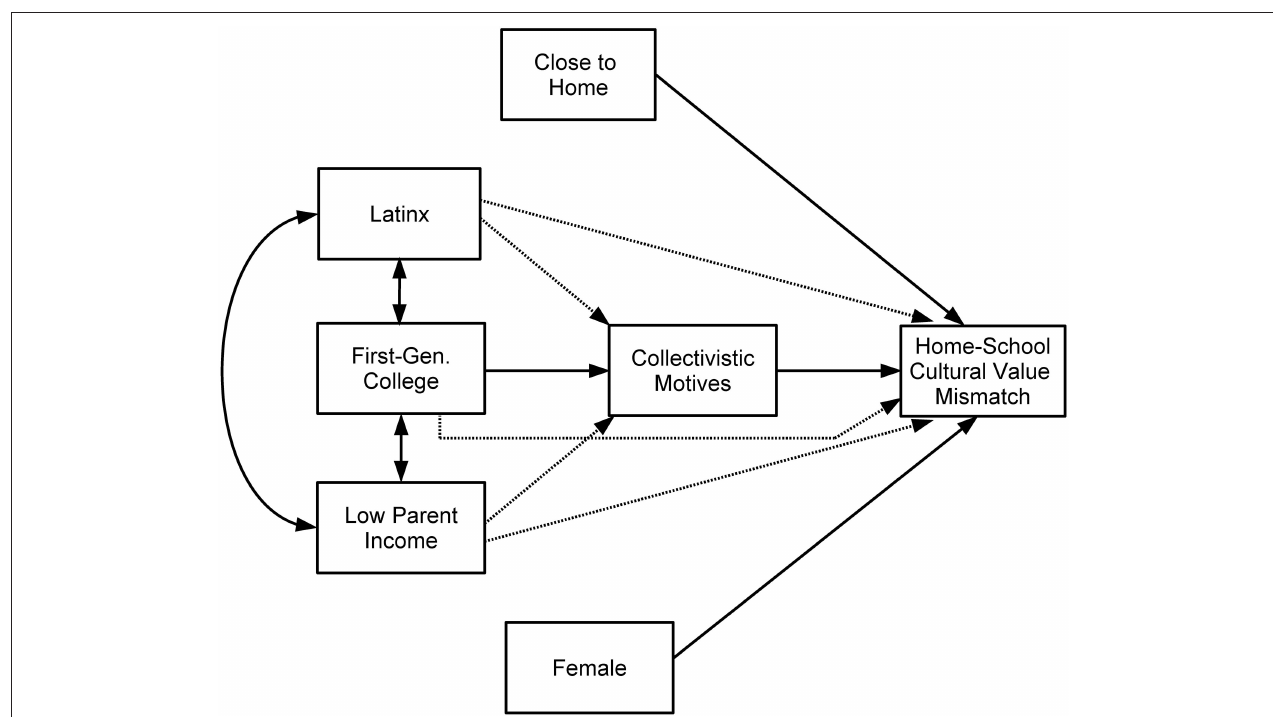
FIGURE 1 | Hypothesized model for antecedents of home-school cultural value mismatch. A dashed line indicates a non-significant relation was expected within the model. Latinx = Latinx ethnic background (coded as 1) vs. not (coded as 0); First-Gen. College = First-generation college student (students’ parents did not receive a college degree; coded as 1) vs. continuing-generation college student (coded as 0); Female = Female (coded as 1) vs. male (coded as